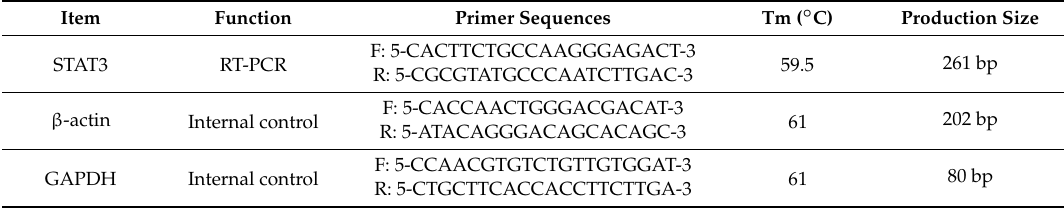
Table 7. Sequences of primer pairs and amplification conditions for